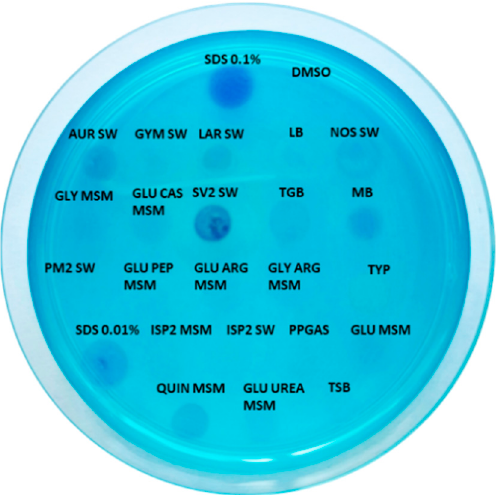
Figure 4. Biosurfactant activity of all extracts (25 mg/mL) on a CTAB agar plate. Blue halos indicate positivity to the test. SDS 0.1% and 0.01% are positive controls, while DMSO vehicle was used as negative